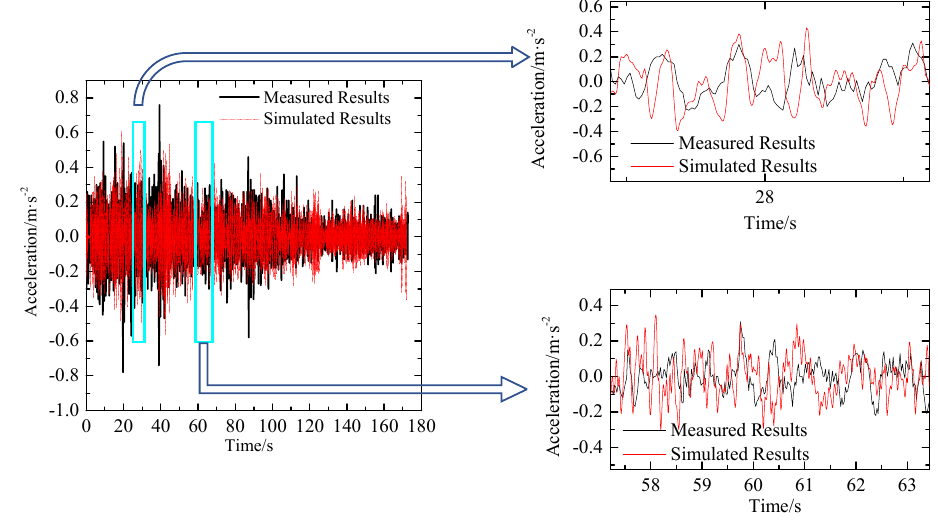
Figure 6. Validation of the vehicle dynamics model.